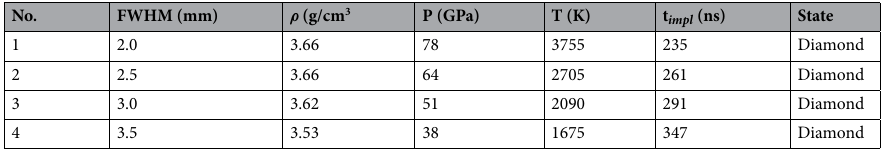
Table 9. Achieved physical conditions in compressed carbon using bunch intensity = 10 11 uranium ions, bunch length = 200 ns, particle energy = 2 GeV/u, initial sample radius, R si = 300 μm, sample mass = 6.4 mg/ cm.